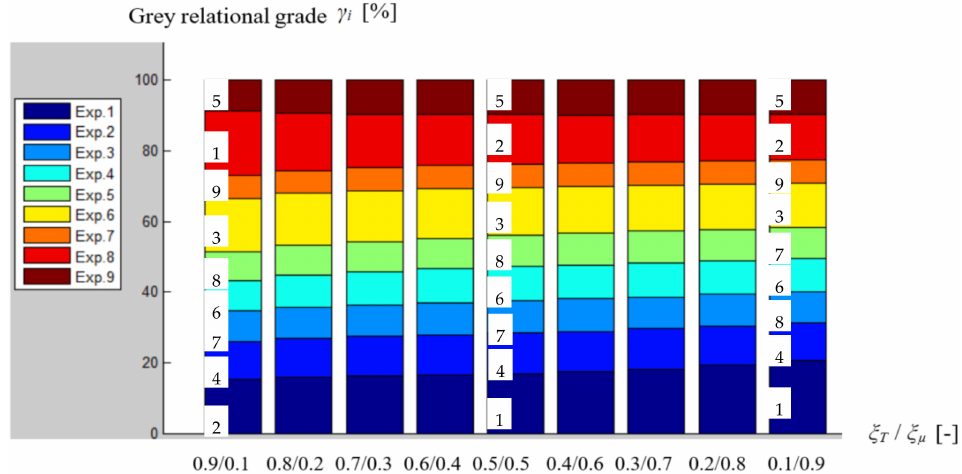
Figure 2. Influence exerted by the decrease of the ratio ξ T / ξµ on the size of the grey relational grade γ i , for all nine experimental tests, in the case of using polyester that includes particles of molybdenum